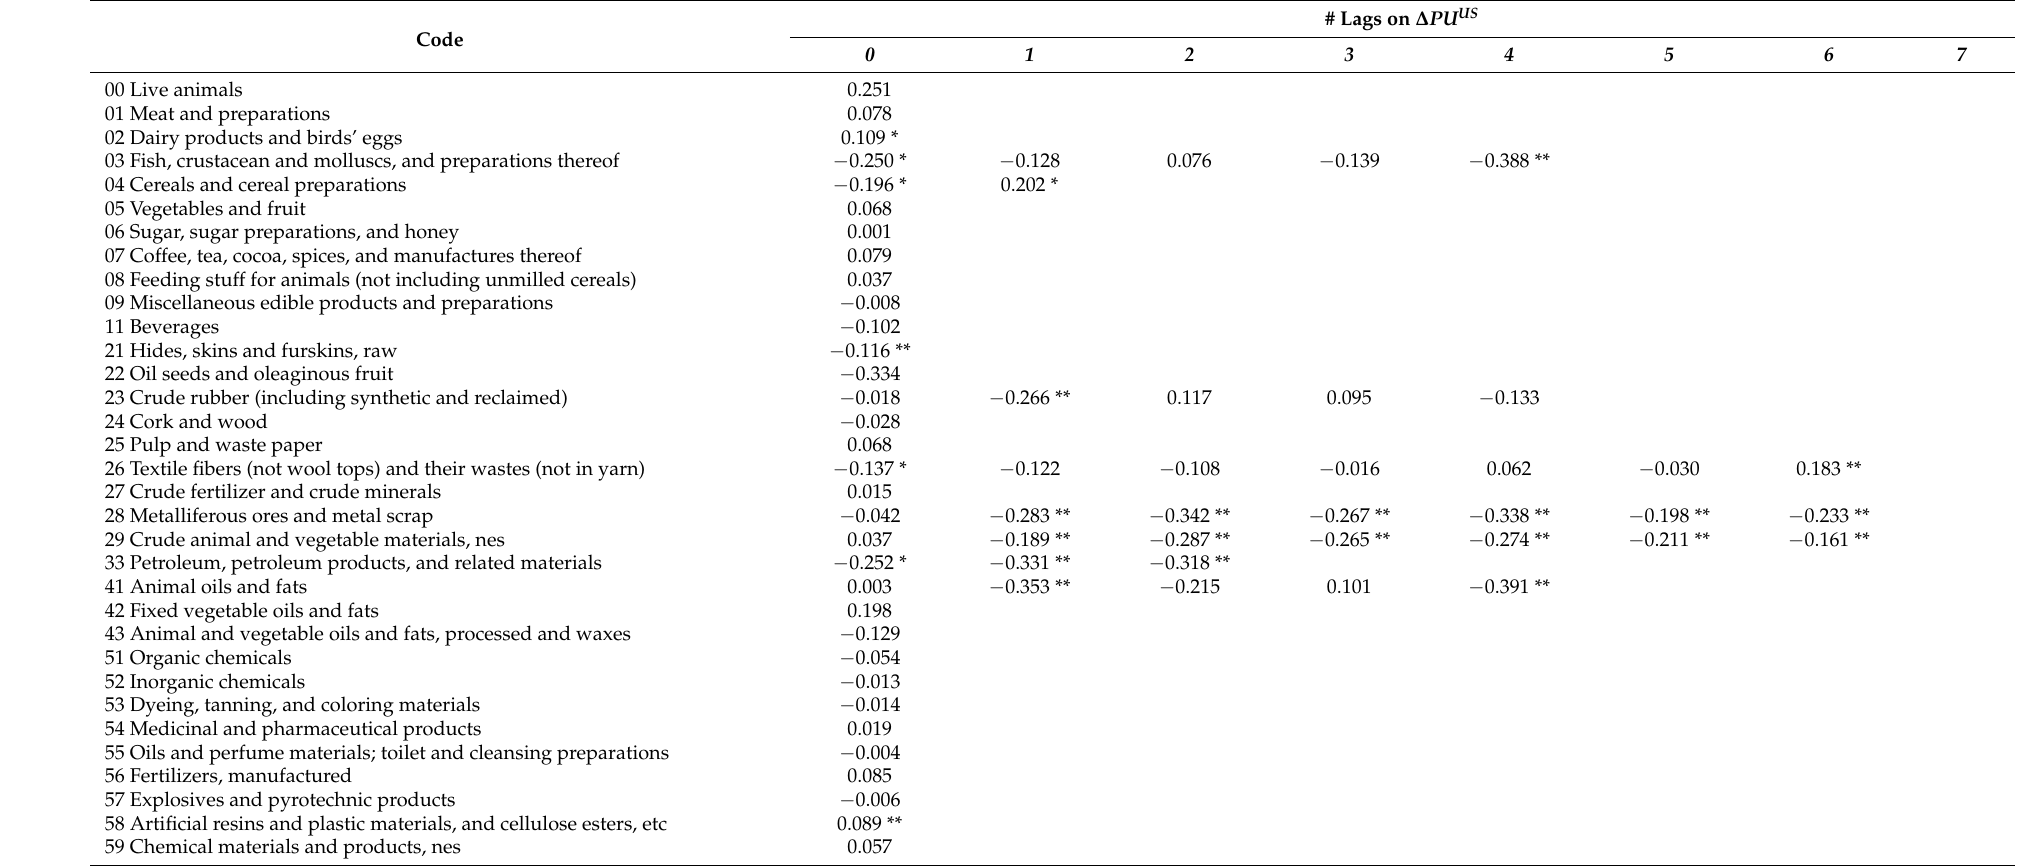
Table 2. Short-Run coefficient estimates of US economic policy uncertainty on U.S. exports to